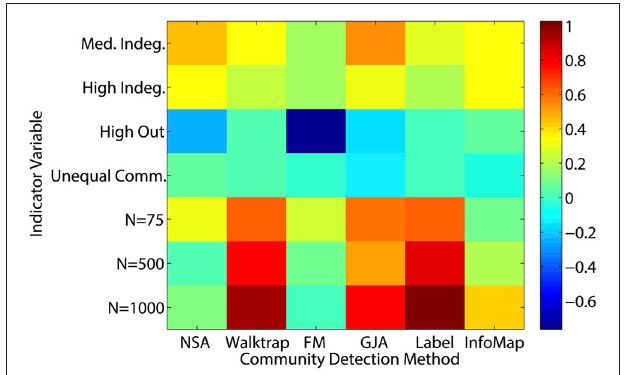
FIGURE 5 | Heatmap of multiple regression results for LFR count matrices. Standardized betas are depicted from multiple regressions conducted for each method using the condition indicator variables to predict ARI HA . “Med” = medium; “Indeg.” = in-degree; “Comm.” = Community; “N” refers to graph size; Reference category is: N = 25, equal community sizes, low proportion of outdegree, and low